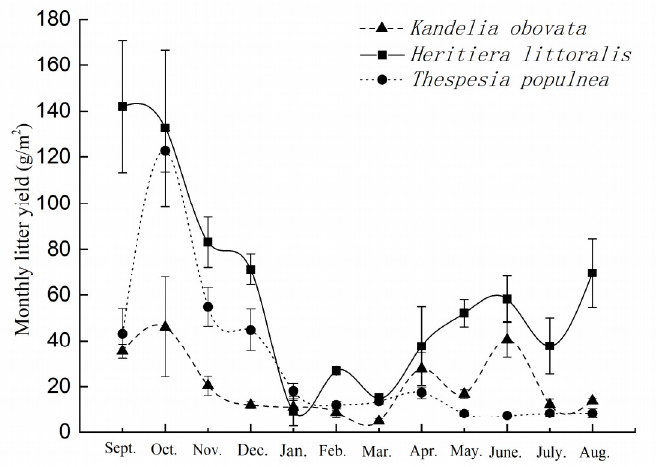
Figure 2. The monthly change in litter yield of the three mangrove species.